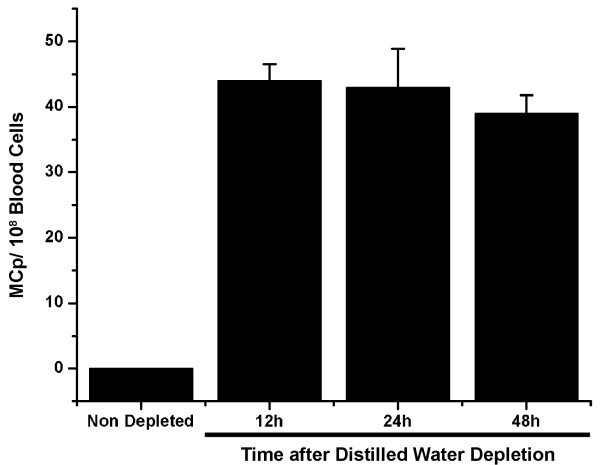
MCp could be immunomagnetically isolated from the blood after mast cell depletion of the peritoneal cavity . Blood was collected by cardiac puncture from nondepleted animals and animals whose peritoneal cavity had been depleted of mast cells by distilled water. By 12 hours after depletion it was possible to isolate MCps from cardiac blood. Only MCps could be isolated from cardiac blood using immunomagnetic beads conjugated to mAbBGD6. Mast cells were isolated from the blood using magnetic beads conjugated to mAb BGD6. The number of cells free or attached to the magnetic beads was determined by counting the cells in a hemocytometer. A minimum of 10 animals were used per time point. Data is expressed as the number of mast cells/108 blood cells ± S.D.